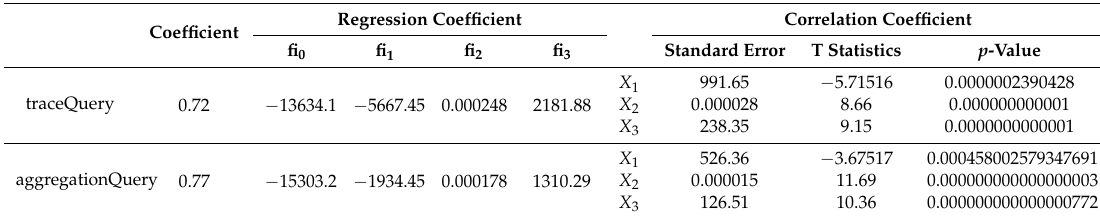
Table 2. Regression